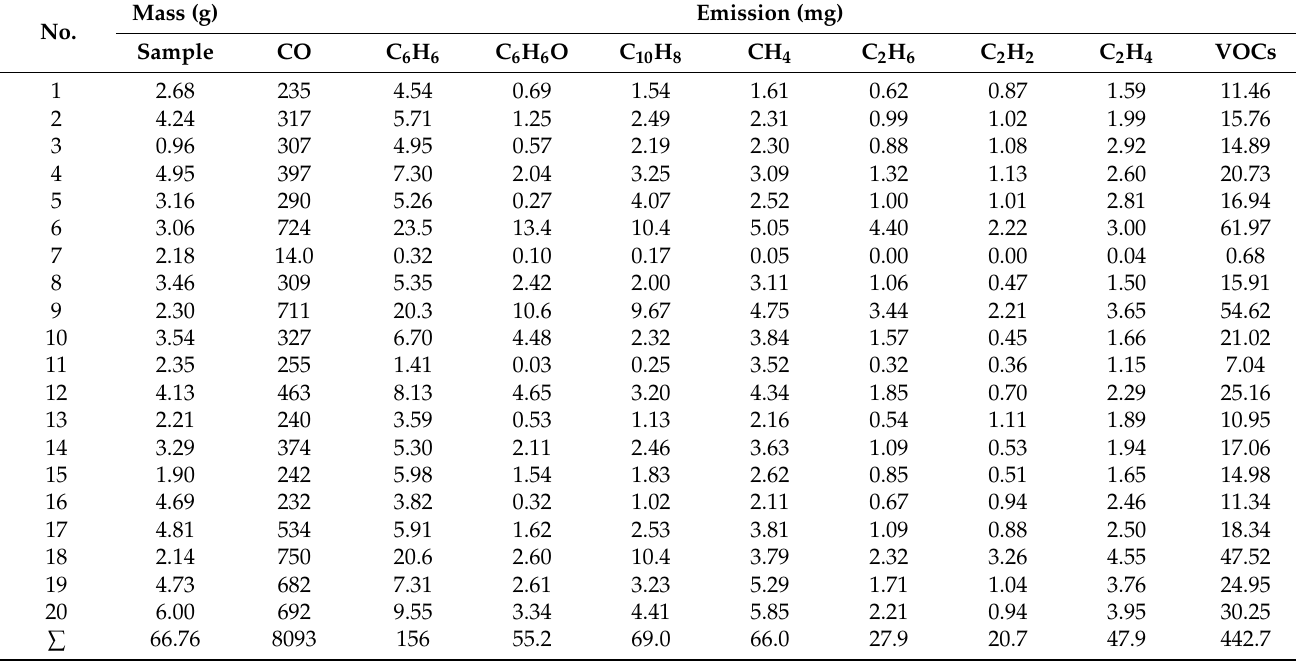
Table 4. Emission of CO, VOC, aliphatic and aromatic hydrocarbons and phenol in the exhaust gases obtained during thermal treatment of waste mobile phones in a fluidised bed. Mass No.